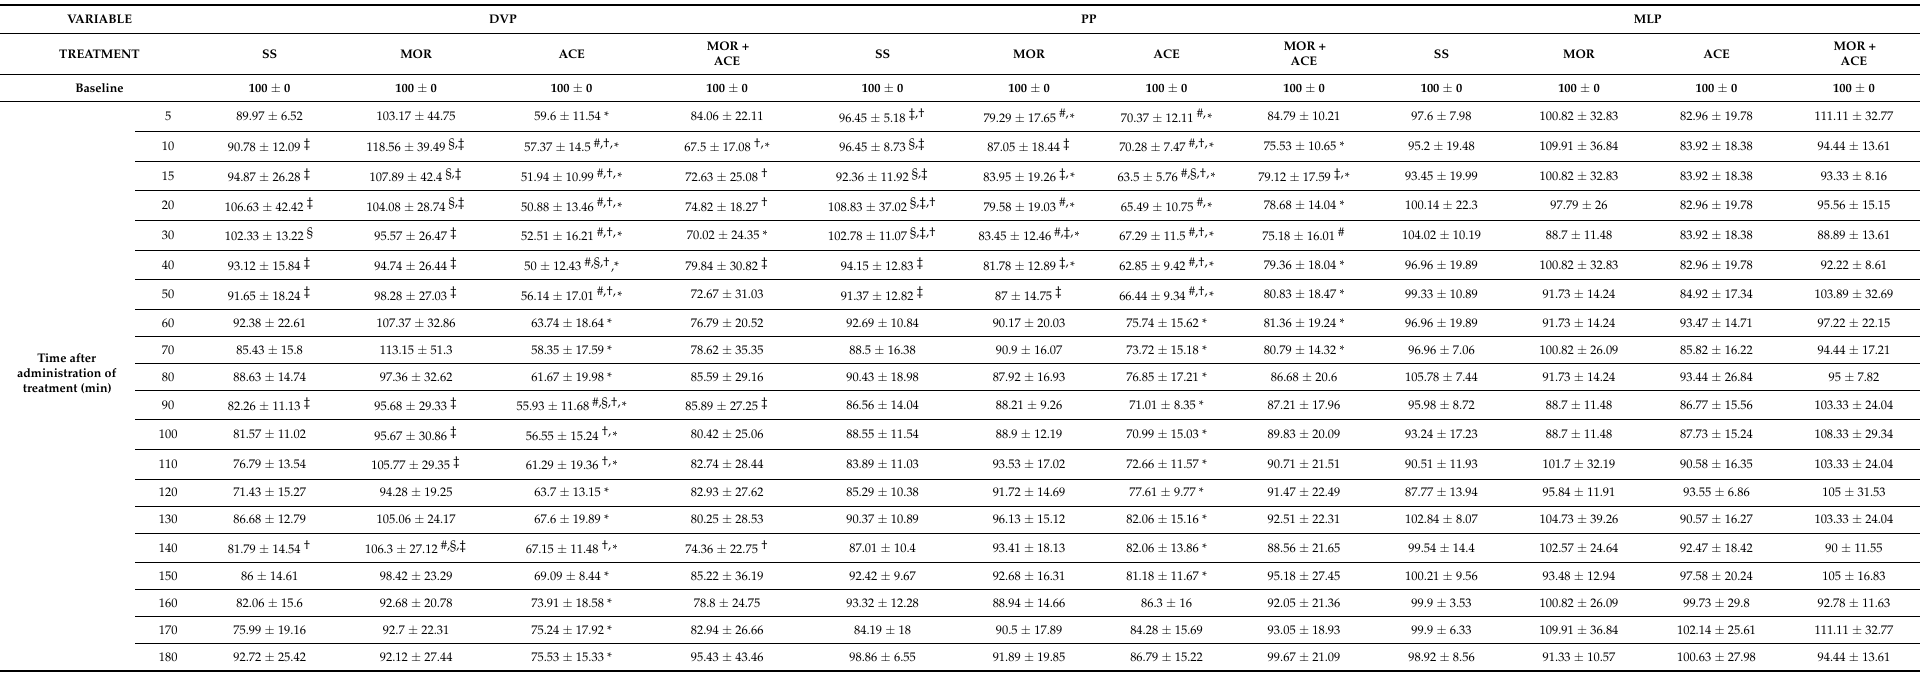
Table 3. Values at walk of energetic variables at − 10, 5, 10, 15, 20, and then every 10 min (total period of 3 h) after IV injection (at 0 min) of 10 mL of sodium chloride (0.9%) solution (SS), 0.2 mg/kg of morphine hydrochloride solution diluted in sodium chloride (0.9%) to a volume of 10 mL (MOR), 0.02 mg/kg of